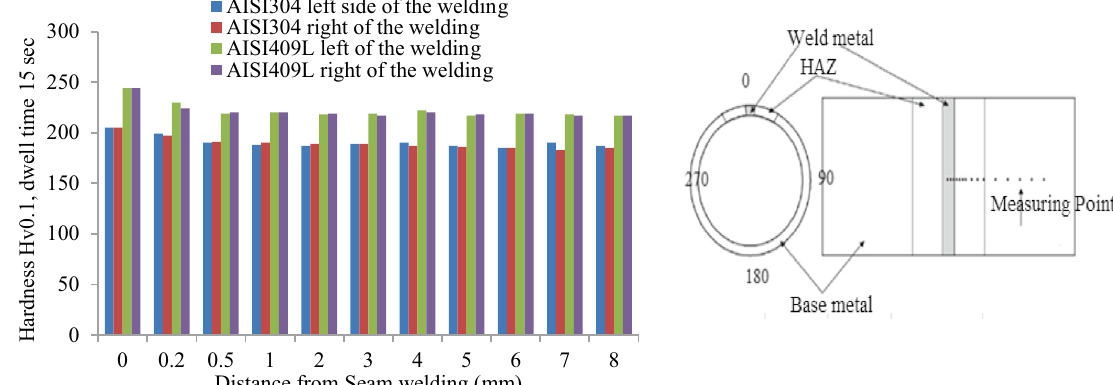
Fig. 4 Measured micro hardness (Experimentally)